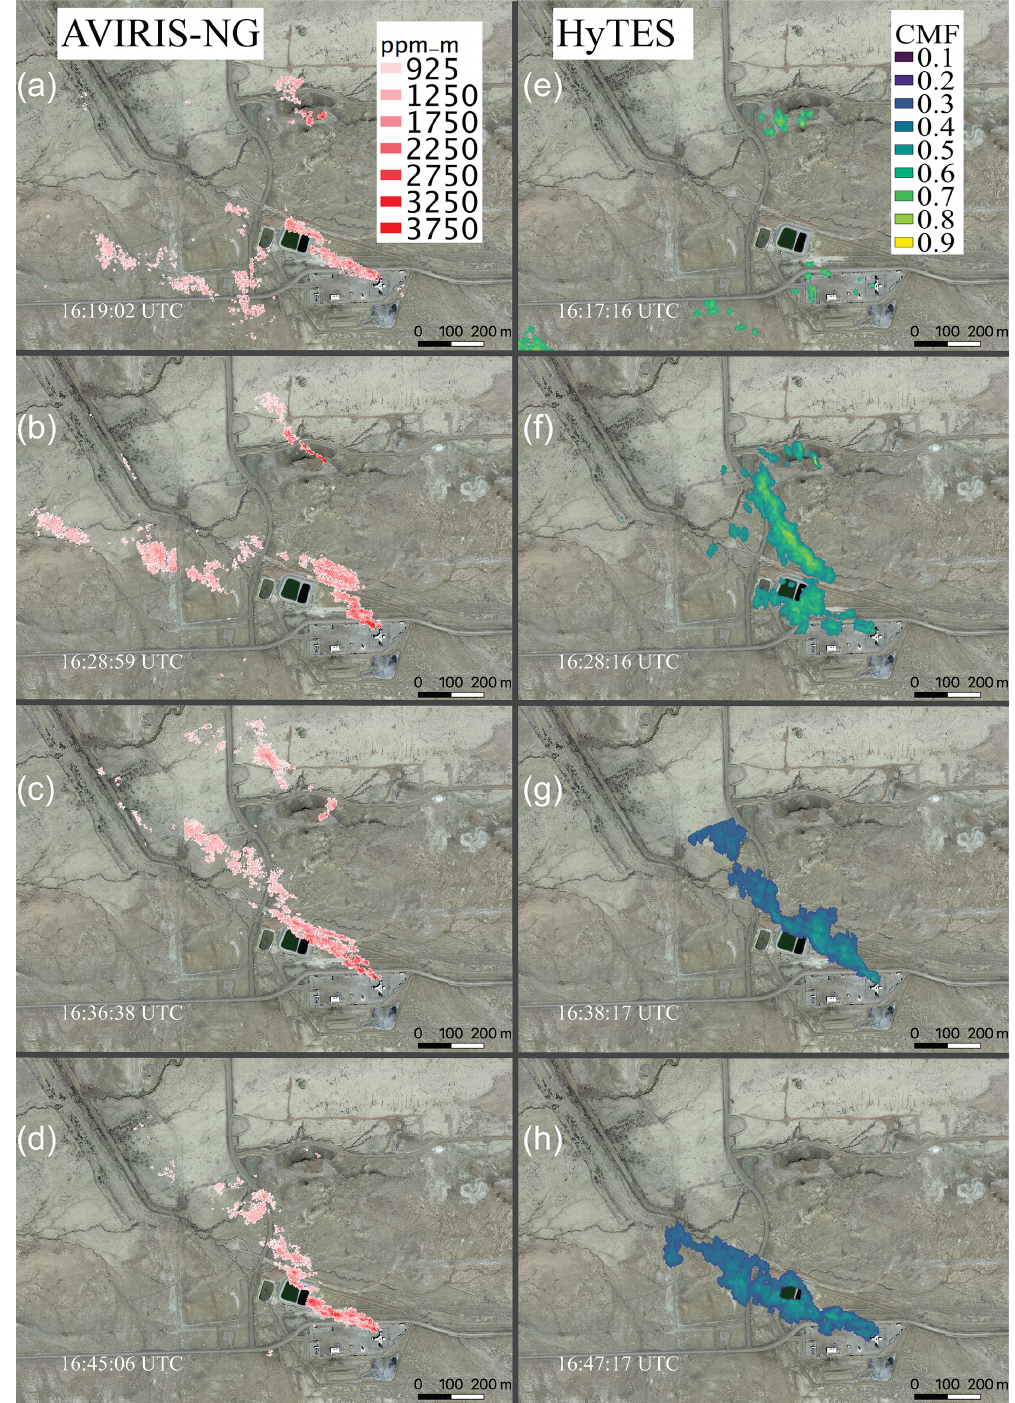
Figure 1. Methane plume over a venting shaft in the Four Corners region, observed from four individual AVIRIS-NG airborne instrument overpasses (2.8m spatial resolution) 7–9min apart on 22 April 2015 between 16:19:02 and 16:45:06UTC (a–d) compared with observations from HyTES overpasses (2.3m spatial resolution) in the similar interval between 16:17:16 and 16:47:17UTC (e–h) . The background is from ©Google Earth